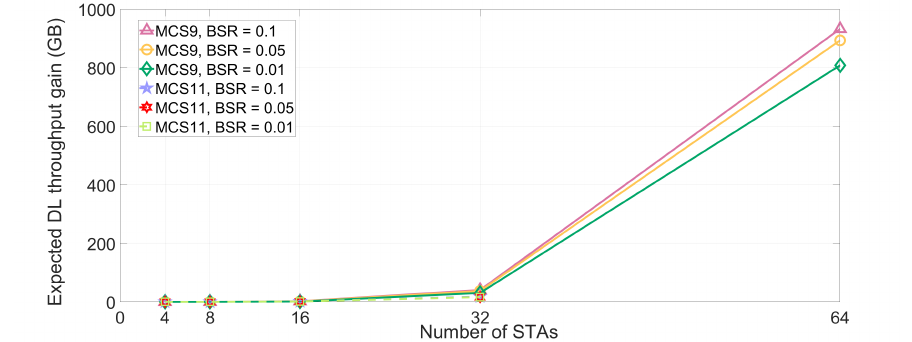
Figure 9. Expected throughput gain for DL